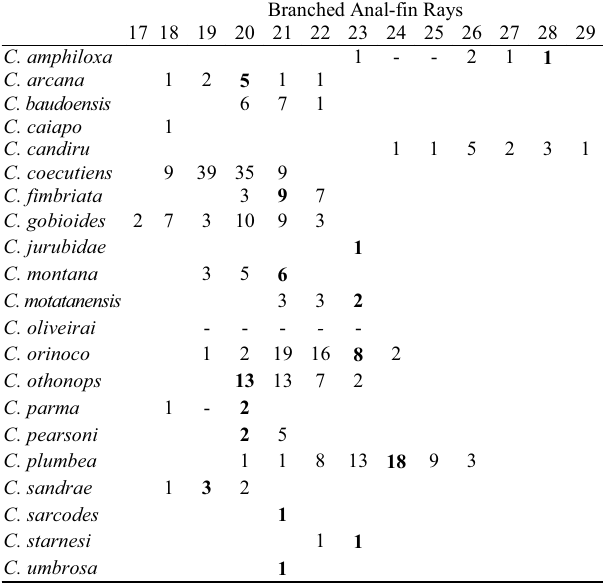
Table 10. Number of specimens of the species of Cetopsis with cited number of branched anal-fin rays. Bold indicates value for holotype or lectotype when examined. Cetopsis oliveirai lacks branched anal-fin